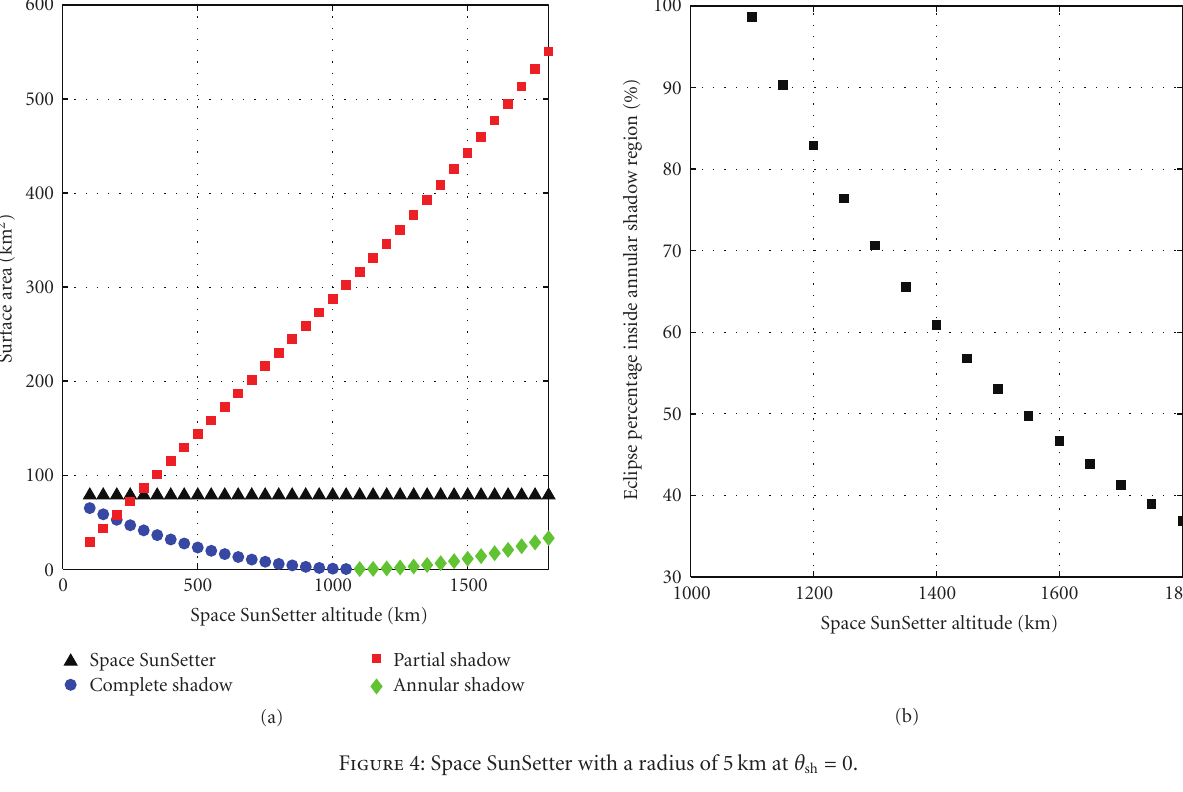
Figure 4: Space SunSetter with a radius of 5 km at θ sh = 0.